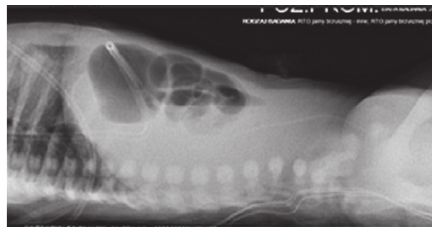
Figure 1: Abdominal X-ray on the first day of life—dilated stomach and bowel loops.